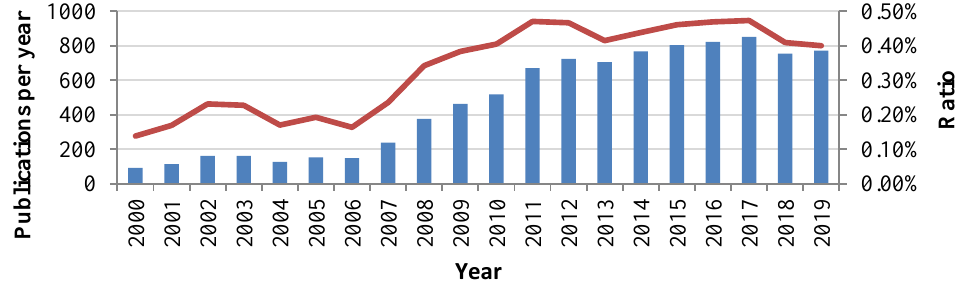
Figure 2. Publications per year (blue histogram) and ratio between publications in the Bioenergy topic in the sector “Agri” and total publications in Agricultural and Biological Science field (red line).